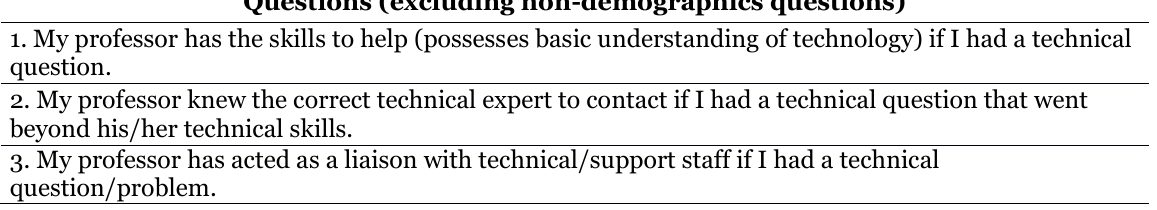
Desired Items for Online Instructors' Outputs Questions (excluding non-demographics